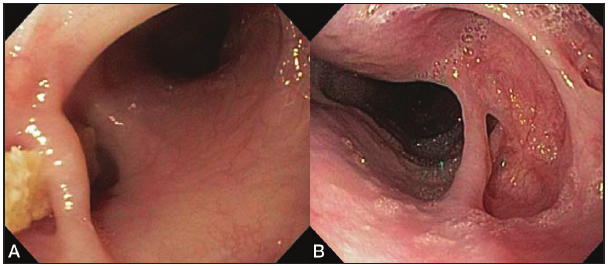
Figure 2) Endoscopic views of mucosal bridge ( A ) with food remnant in